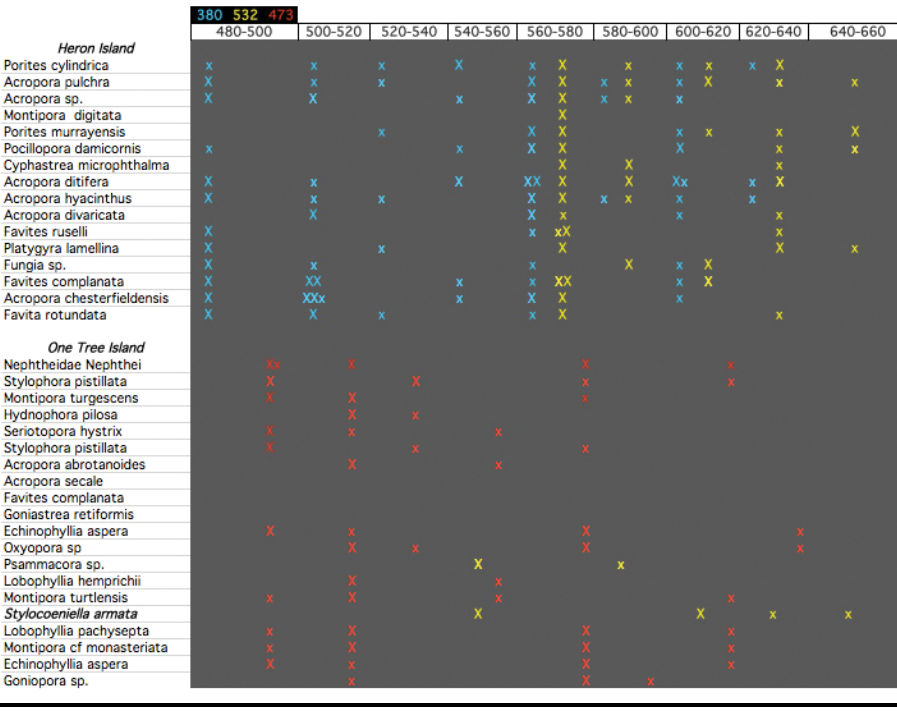
Table 1. Major and minor °uorescence peaks in the studied coral colonies. Big crosses con- tributes to major peaks, small to minor. Color of crosses codes excitation wavelength: blue, yellow and red corresponds to 380, 532 and 473 nm excitation,